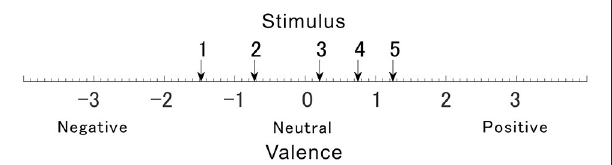
FIGURE 3 | The degree of valence was measured using the Scheffe’s method. Arrows numbered 1–5 indicate affective scale values for each sound.